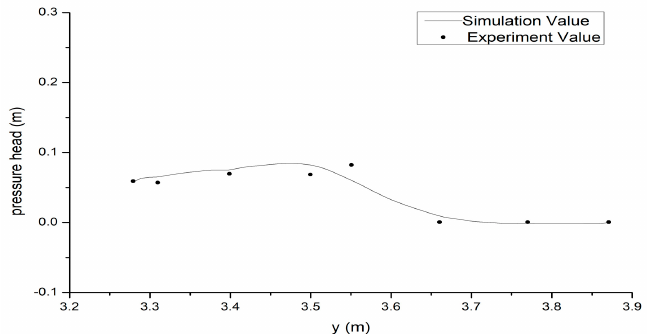
Figure 6. Comparison of experimental and simulated wall pressures with the swallow-tailed bucket.